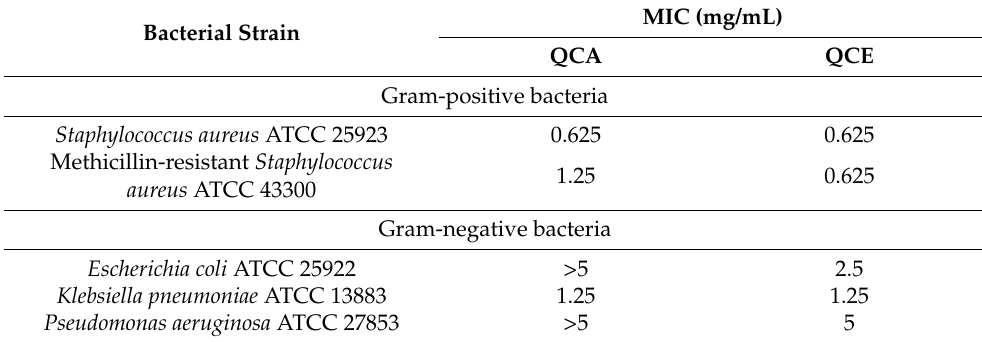
Table 3. Antibacterial activity (MIC in mg/mL) of the Q. cerris bark